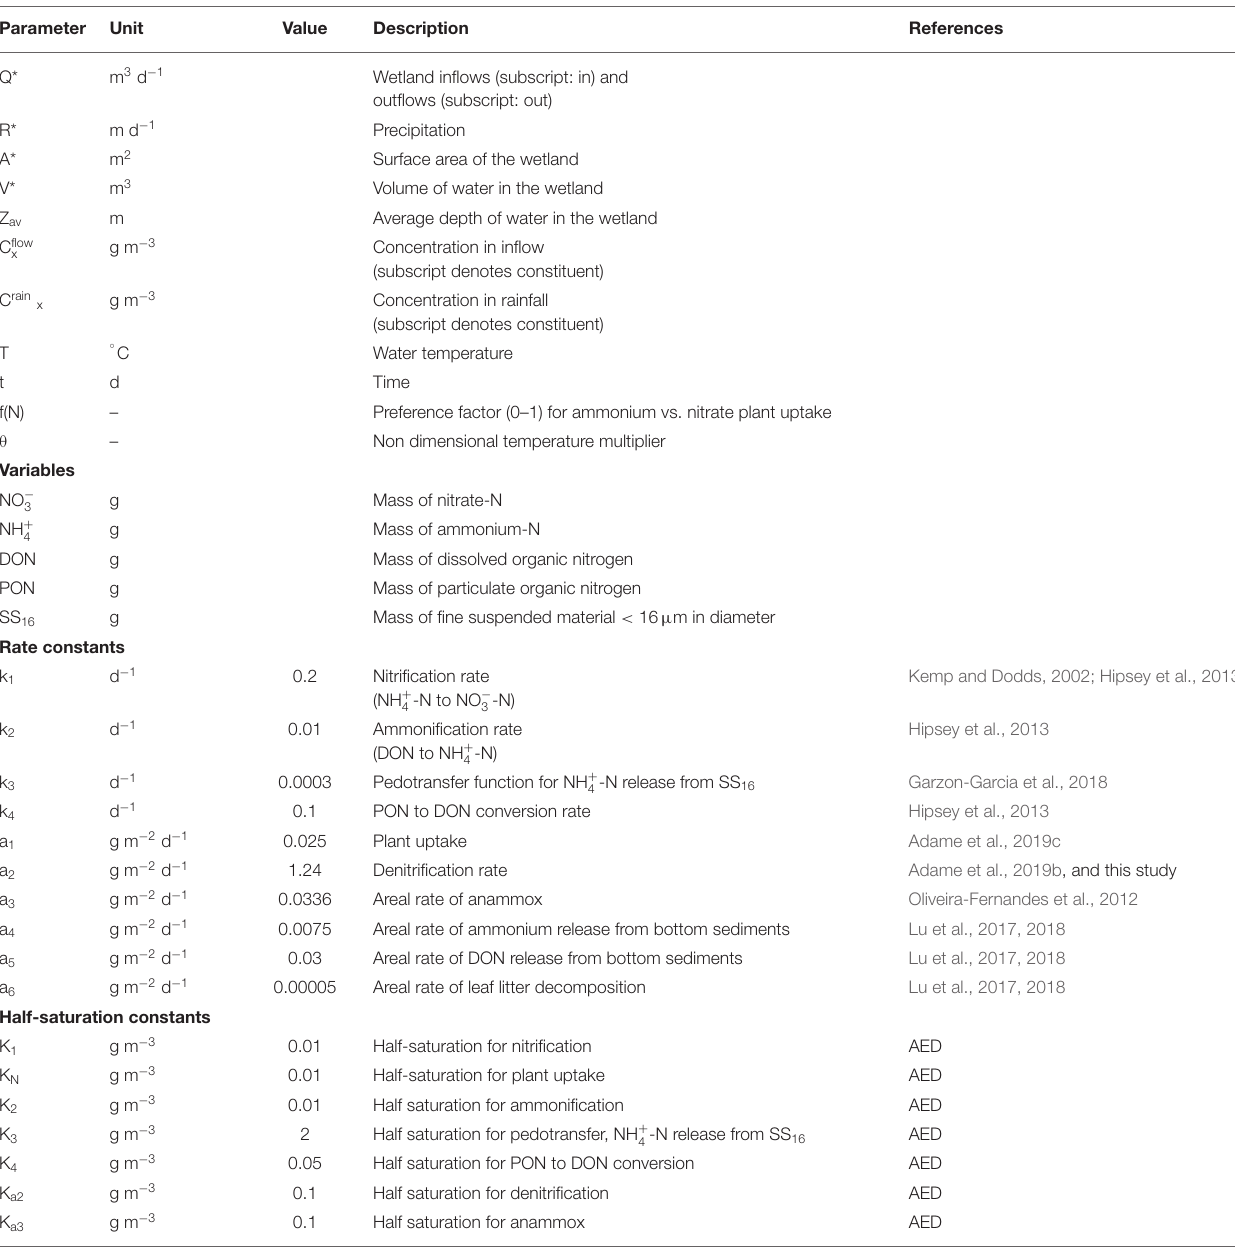
TABLE 1 | Notation for the mathematical model of nitrogen dynamics in wetlands. Parameter Unit